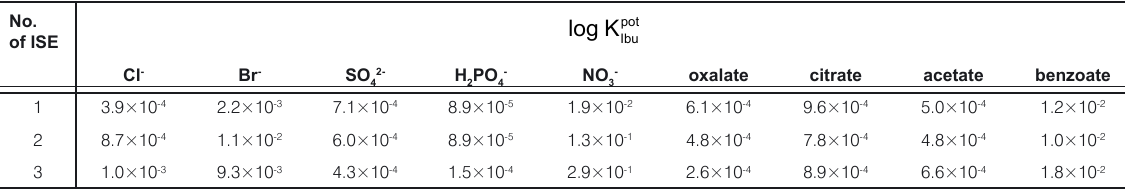
Table 4. Potentiometric selectivity coefficients of ibuprofen electrodes using SSM method.